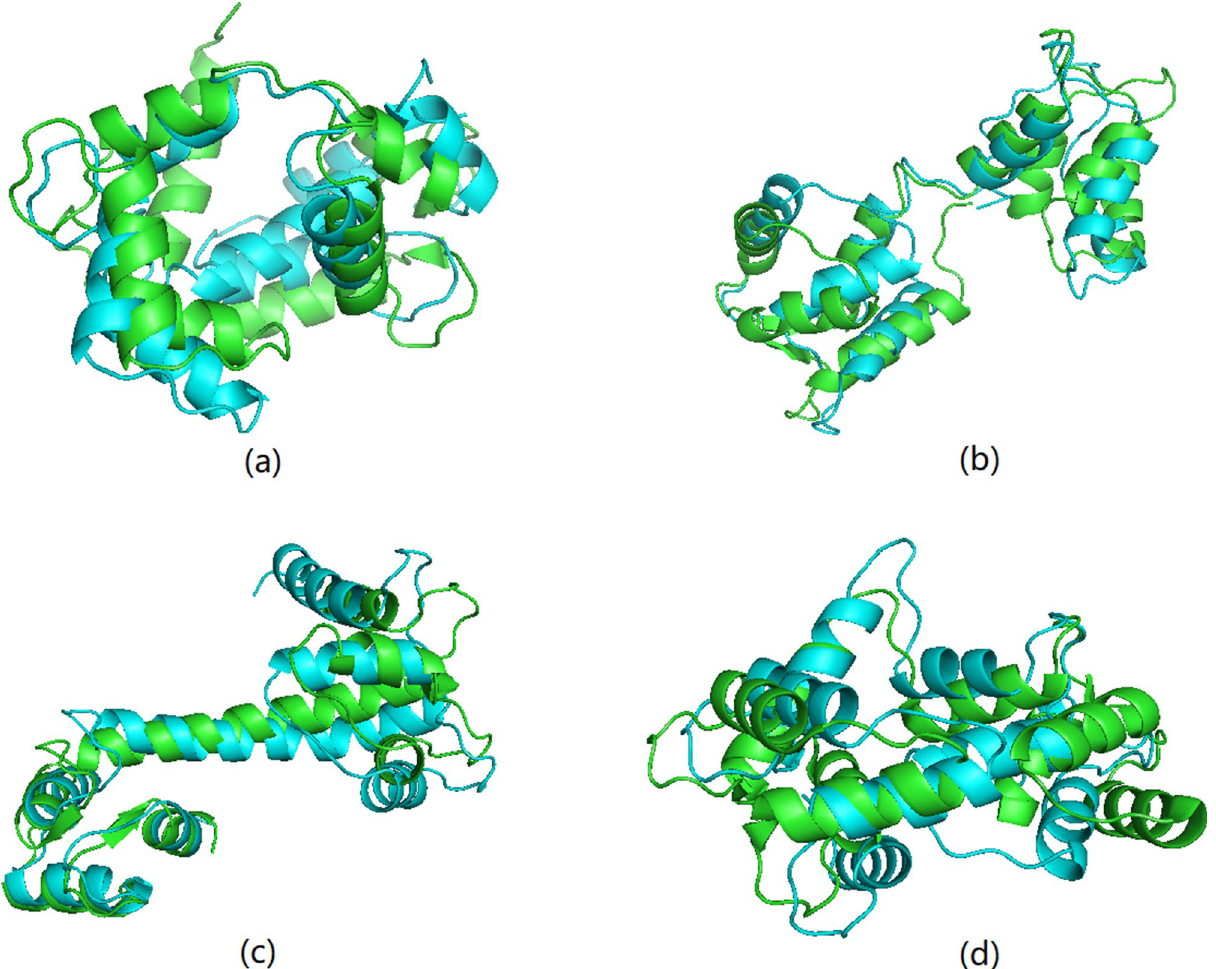
Figure 2. Alignment of empirically determined and predicted structures corresponding to a single amino acid sequence using our method. Known structures are shown in green, and predicted structures in blue, for ( a ) protein 1a29, ( b ) protein 1cfd, ( c ) protein 1cll, and ( d ) protein 2bcx.